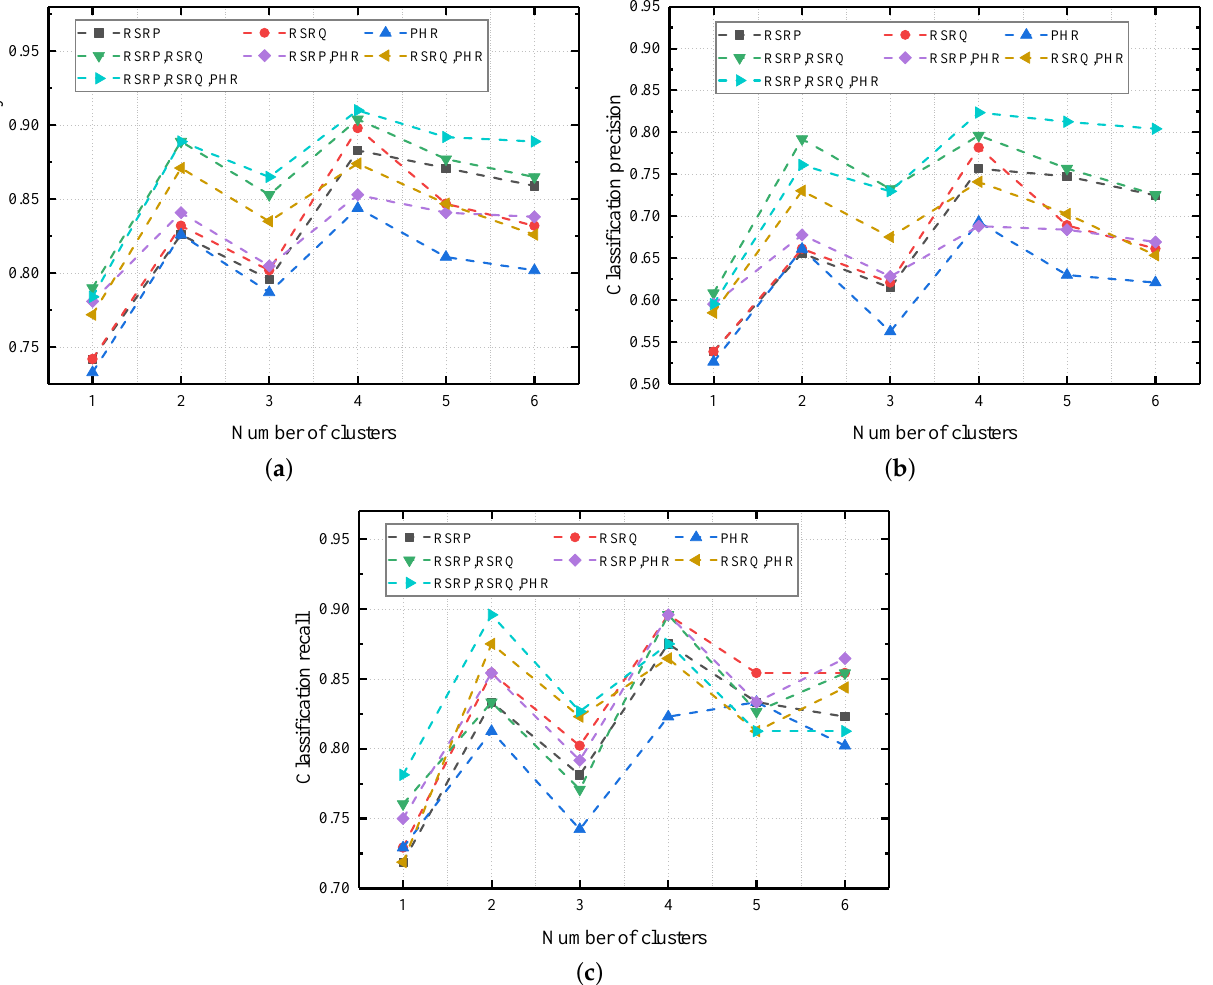
Figure 7. Performance comparison of the feature combinations. ( a ) Classification accuracy. ( b ) Classi- fication precision. ( c ) Classification